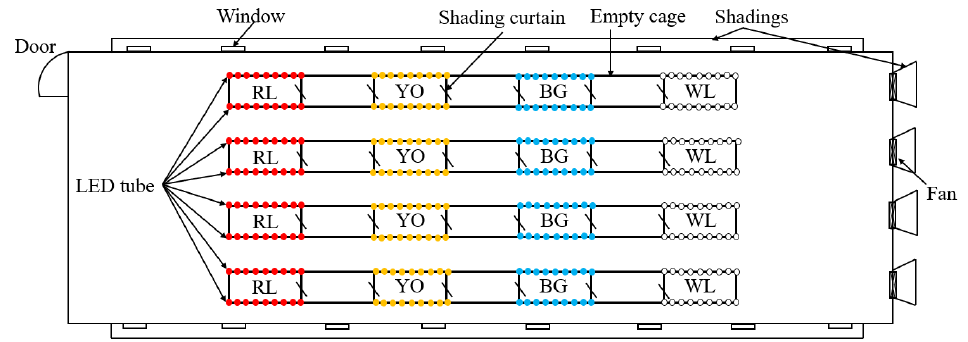
Figure 3. Schematic diagram of the layout of the four LED tubes (WL: white, RL: red, YO: yellow-orange, BG: blue-green). Table 1. Details of measurement samplings.